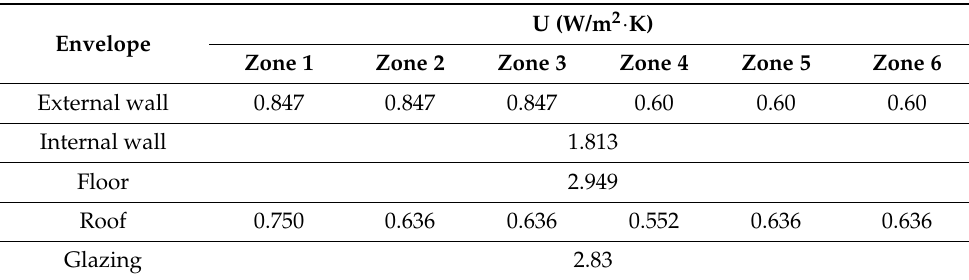
Table 6. Thermal characteristics of the building envelope under Moroccan thermal regulation of construction (MTRC) requirements.